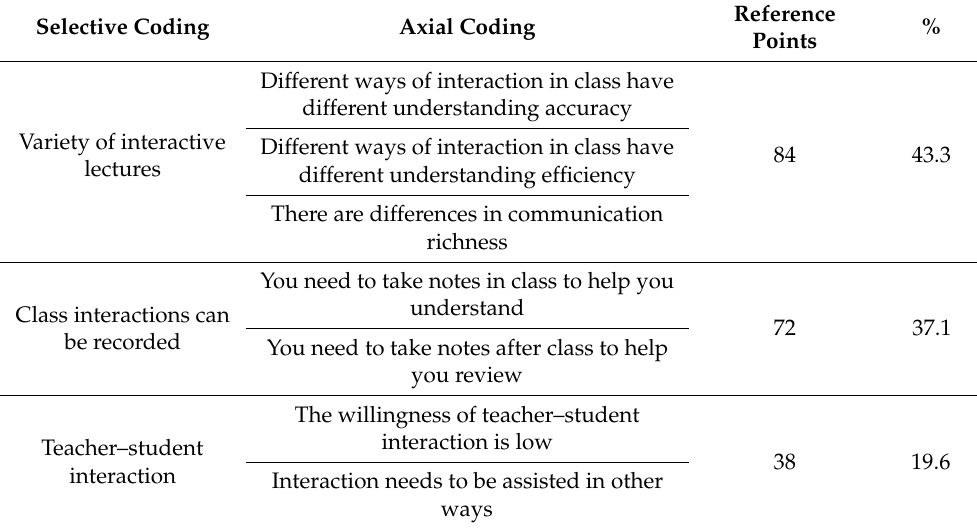
Table 1. The interview coding.